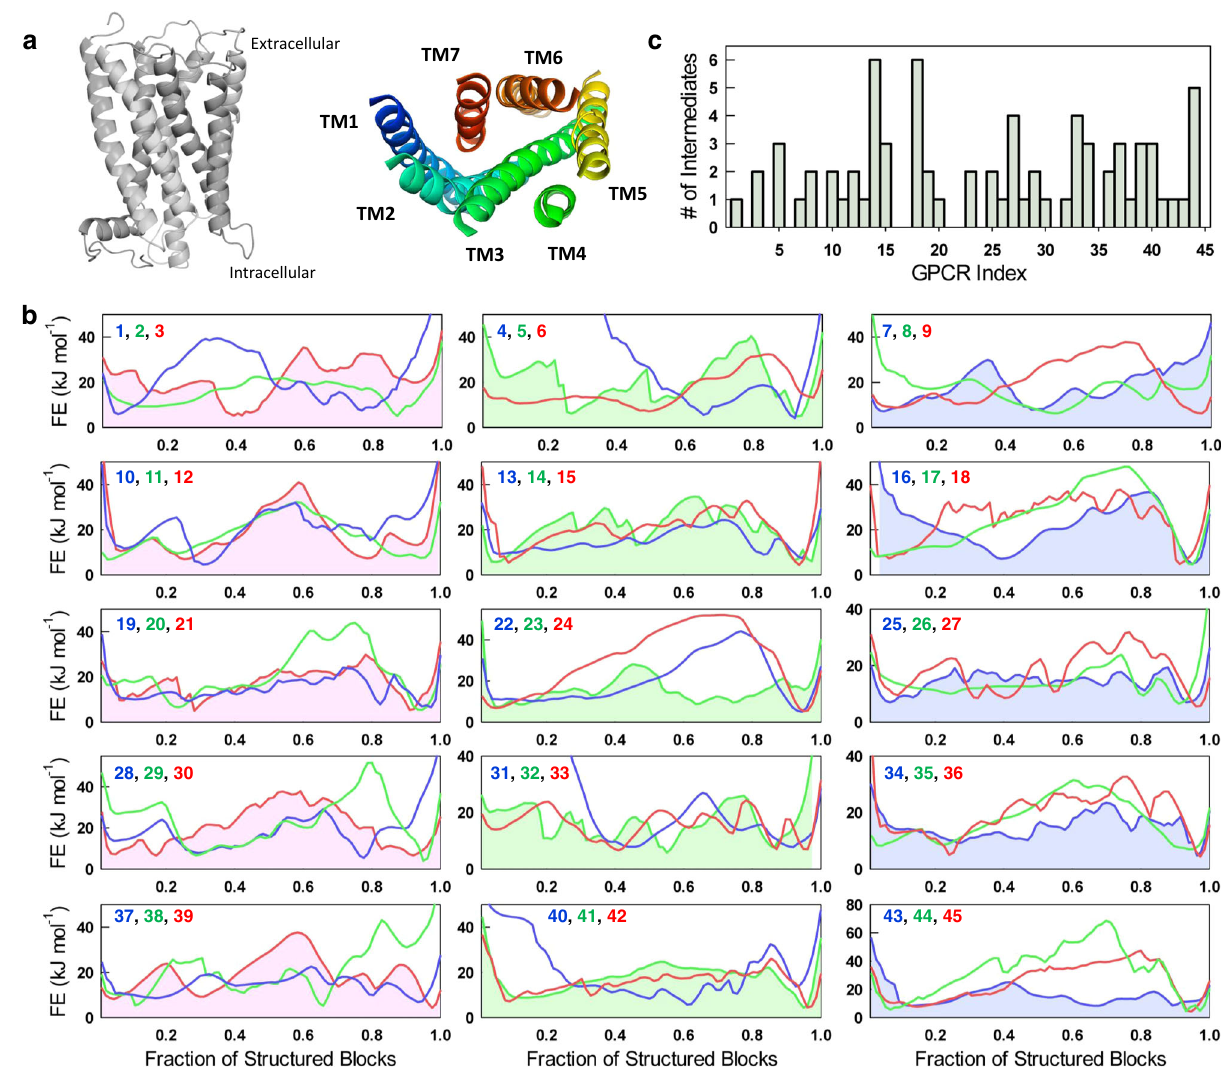
Fig. 1 | GPCR free energy pro fi les. a Representative structure of a GPCR with the seventransmembrane (TM)helicesviewed side on (left)and fromtheextracellular side (right). b One-dimensional free energy (FE) pro fi les of the 45 GPCRs as a functionofthereactioncoordinate,thefractionofstructuredblocks,atthemelting temperature. The more folded conformations populate to the right of the free energy pro fi le (high reaction coordinate values), while the partially structured